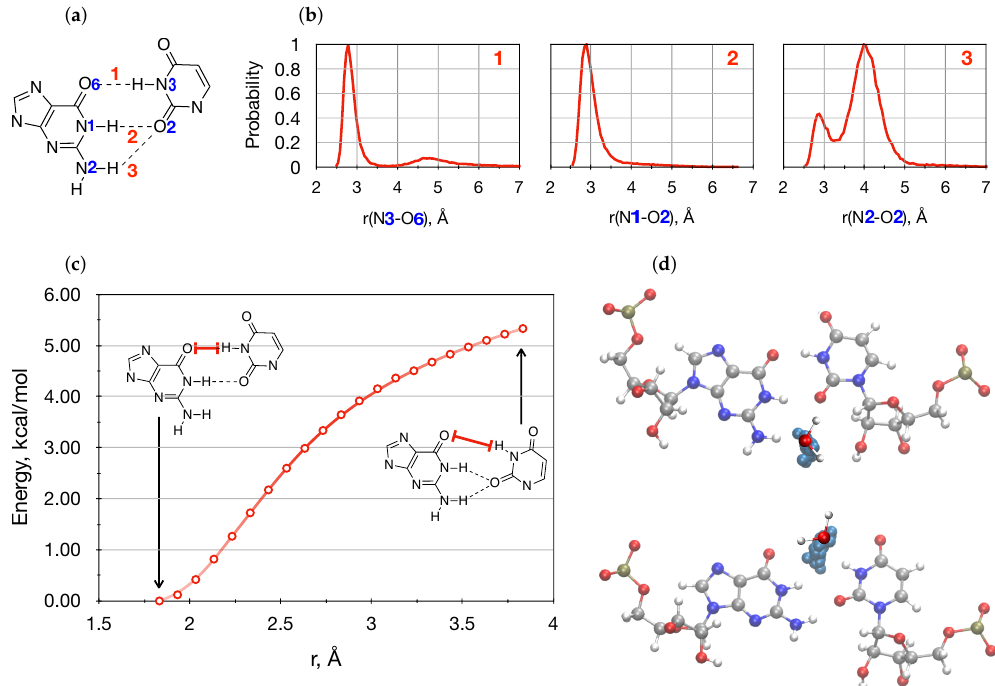
Figure 4. Analyses of MD trajectories reveal two distinct states: ( a ) Three donor–acceptor (DA) distances: 1 N3 · · · O6, 2 N1 · · · O2, and 3 N2 · · · O2. ( b ) Probability distributions of three DA distances. ( c ) Relative energies of G • U base pair along reaction coordinate O · · · H corresponding to DA 1 computed at B3LYP/6-311++G(d,p). ( d ) G • U base pair is represented with balls and sticks, and averaged positions of water molecules are shown in Cyan colored balls in hp-GU-20